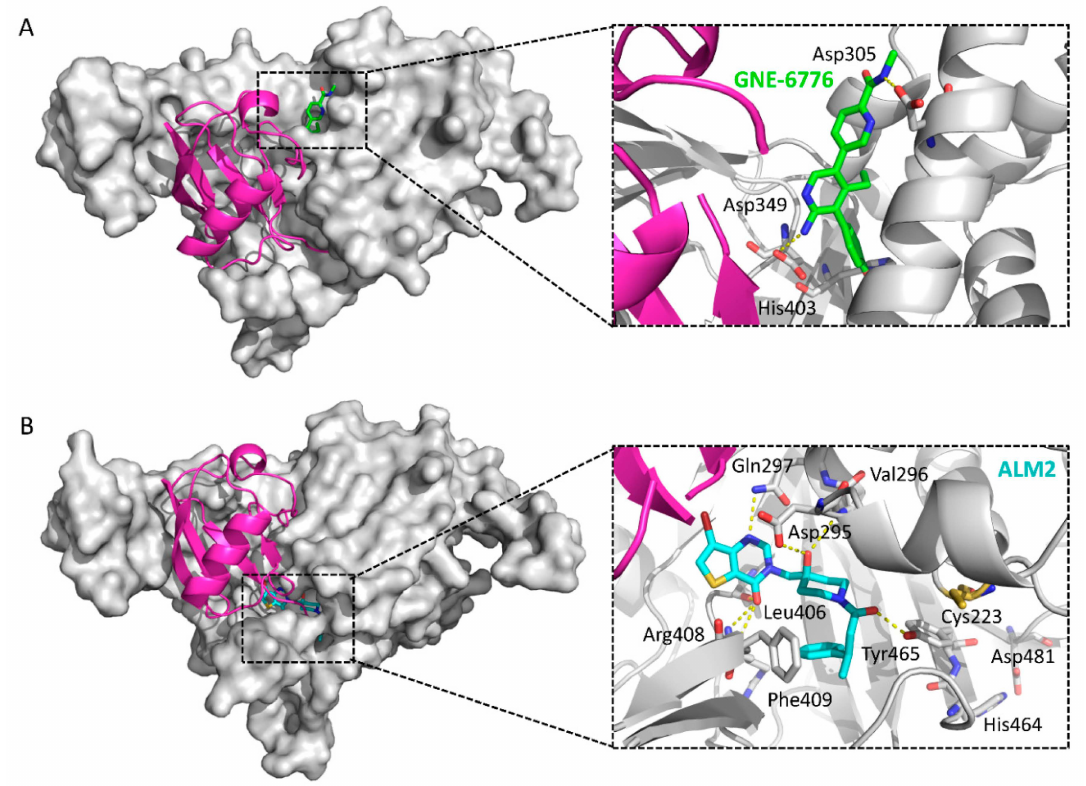
Figure 15. Comparison of the structures of USP7-GNE-6776 (PDB ID: 5UQX) and USP7-ALM2 (PDB ID: 5N9R). A ubiquitin molecule is modeled into the complexes based on a superposition with a USP7CD-ubiquitin complex (PDB ID: 1NBF). Ubiquitin: magenta; USP7 catalytic domain: gray; GNE-6776: green sticks; ALM2: cyan sticks. Hydrogen bonds: yellow dotted lines. Key residues involved in binding: sticks. ( A ) Crystal structure of USP7-GNE-6776 and a close-up of the GNE-6776-binding site. In the close-up figure, the ubiquitin peptide AGKQLED is omitted for clarity. ( B ) Crystal structure of USP7-ALM2 and a close-up of the ALM2-binding site. In the close-up figure, the catalytic triad of USP7 (Cys223-His464-Asp481) is also shown as sticks, with Cys223 in orange, and the ubiquitin C-terminal peptide LRLRGG is omitted for